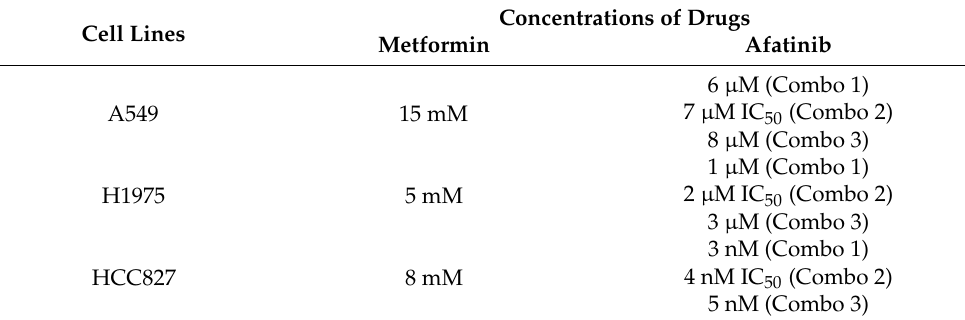
Table 1. Scheme of treatment concentrations for each cell line. Cell